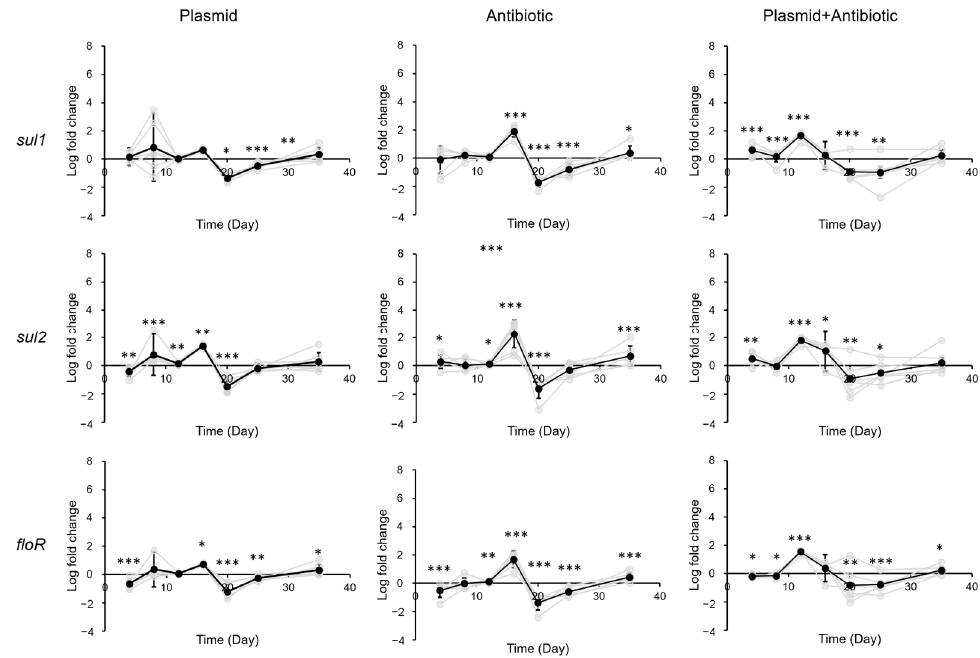
Figure 3. Change in ARG levels in mouse small intestine after exposure to pR55 (plasmid), sulfadi- azine (antibiotic), or pR55 + sulfadiazine (plasmid + antibiotic). Each gray line indicates a mouse group (male groups 1–3, female groups 1–3). Black line indicates average of all six groups. Error bars indi- cate standard deviation of 6 replicates (3 males and 3 females). *, p < 0.05; **, p < 0.01; ***, p < 0.001.